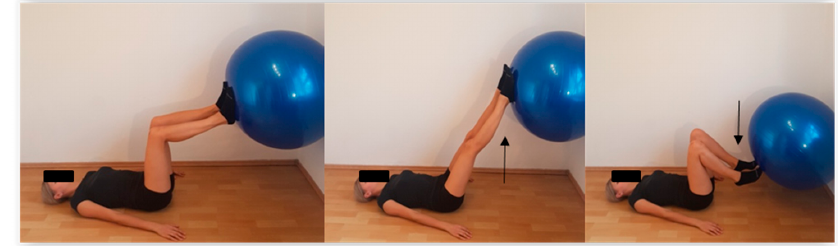
Figure 2. Exercise protocol for the ball-rolling